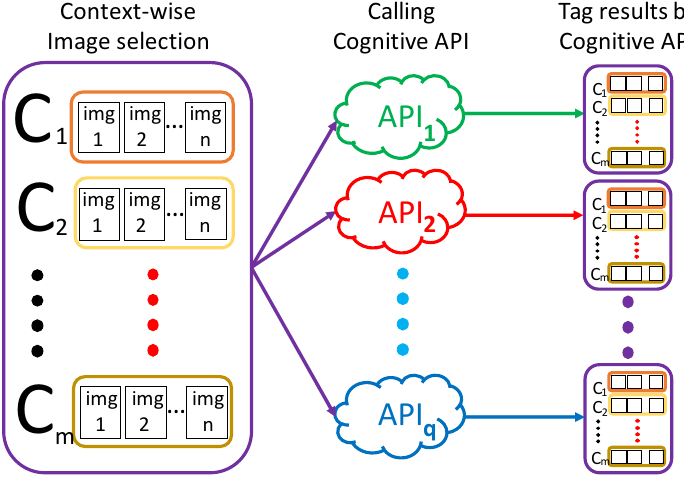
Figure 1. The flow from context label setting to analysis of